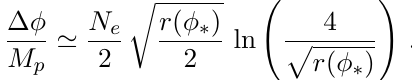
= 10 3 , 10 4 and 10 5 0